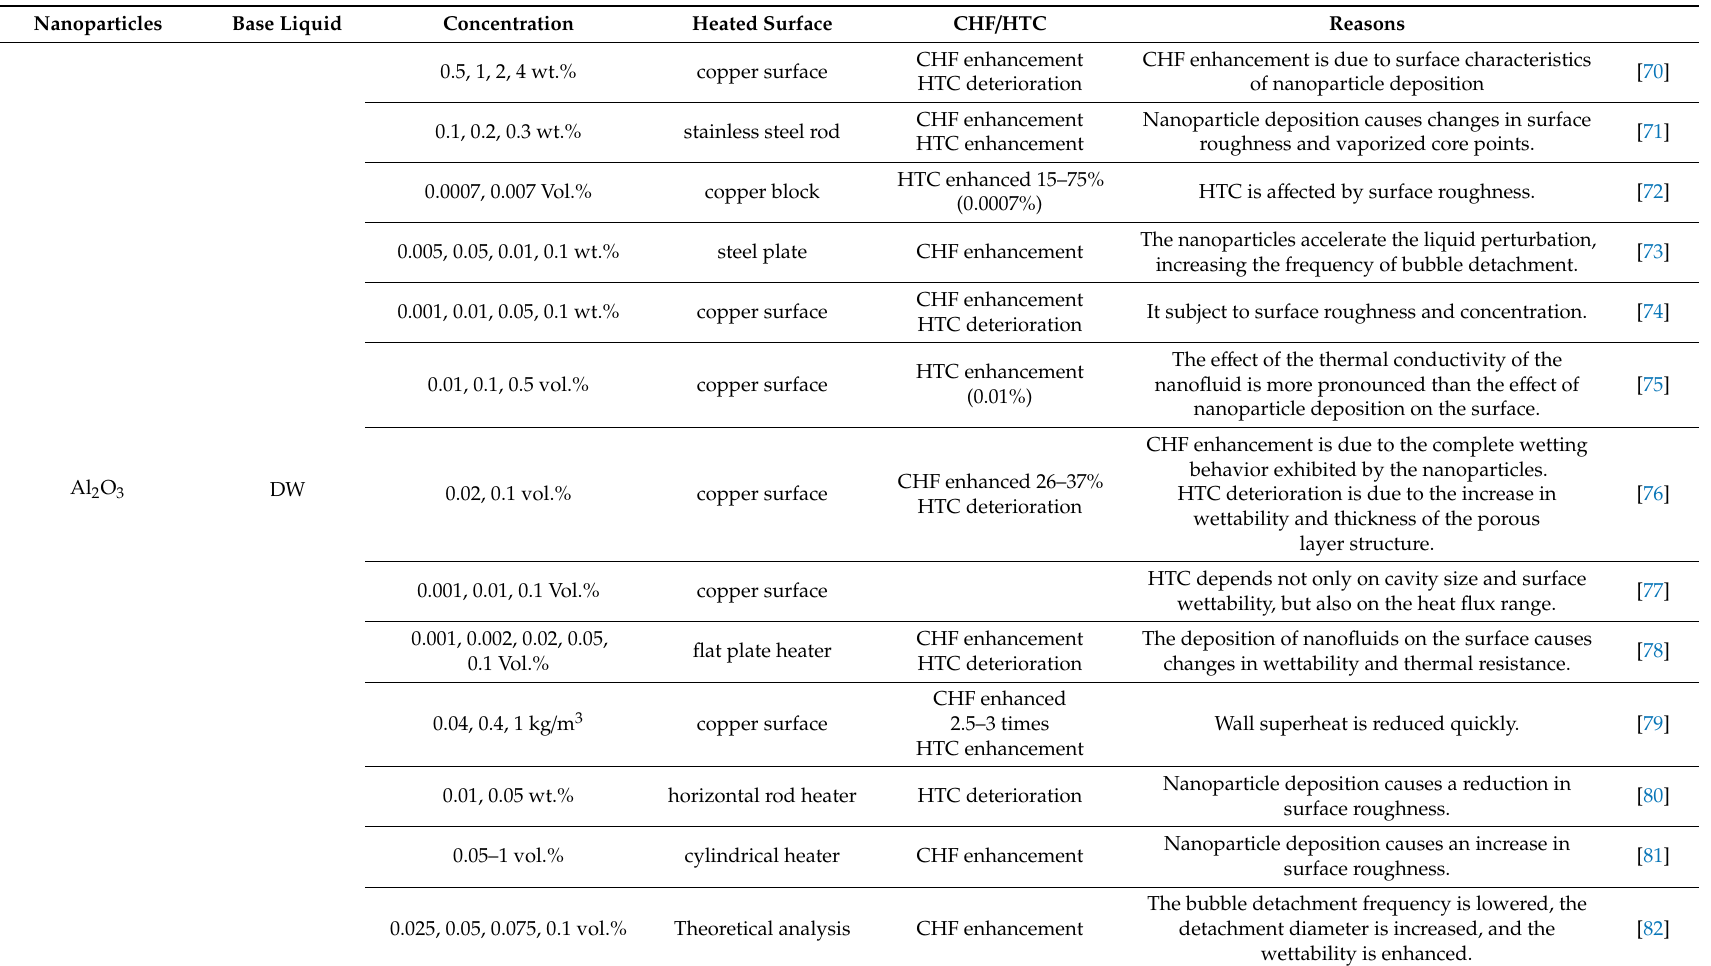
Table 1. Nanofluid boiling heat